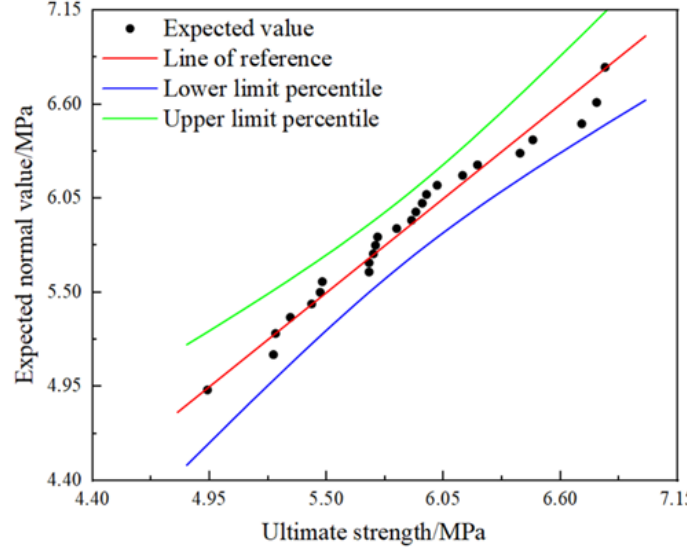
Figure 9. Distribution of ultimate strength.